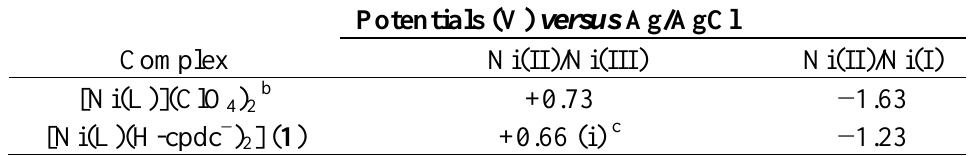
Table 4. Cyclic voltammetric data a .